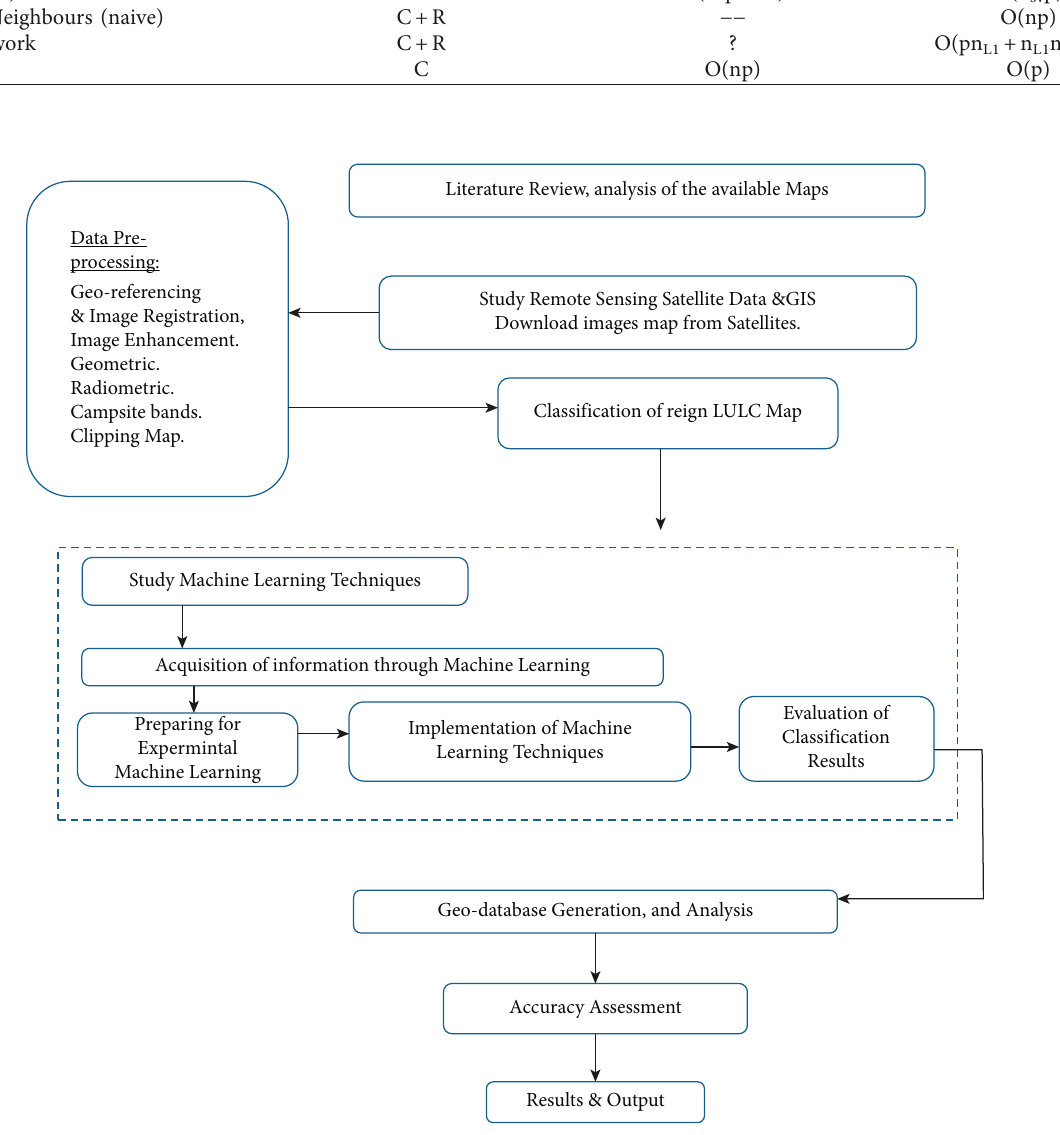
Figure 1: Workflow diagram for proposed